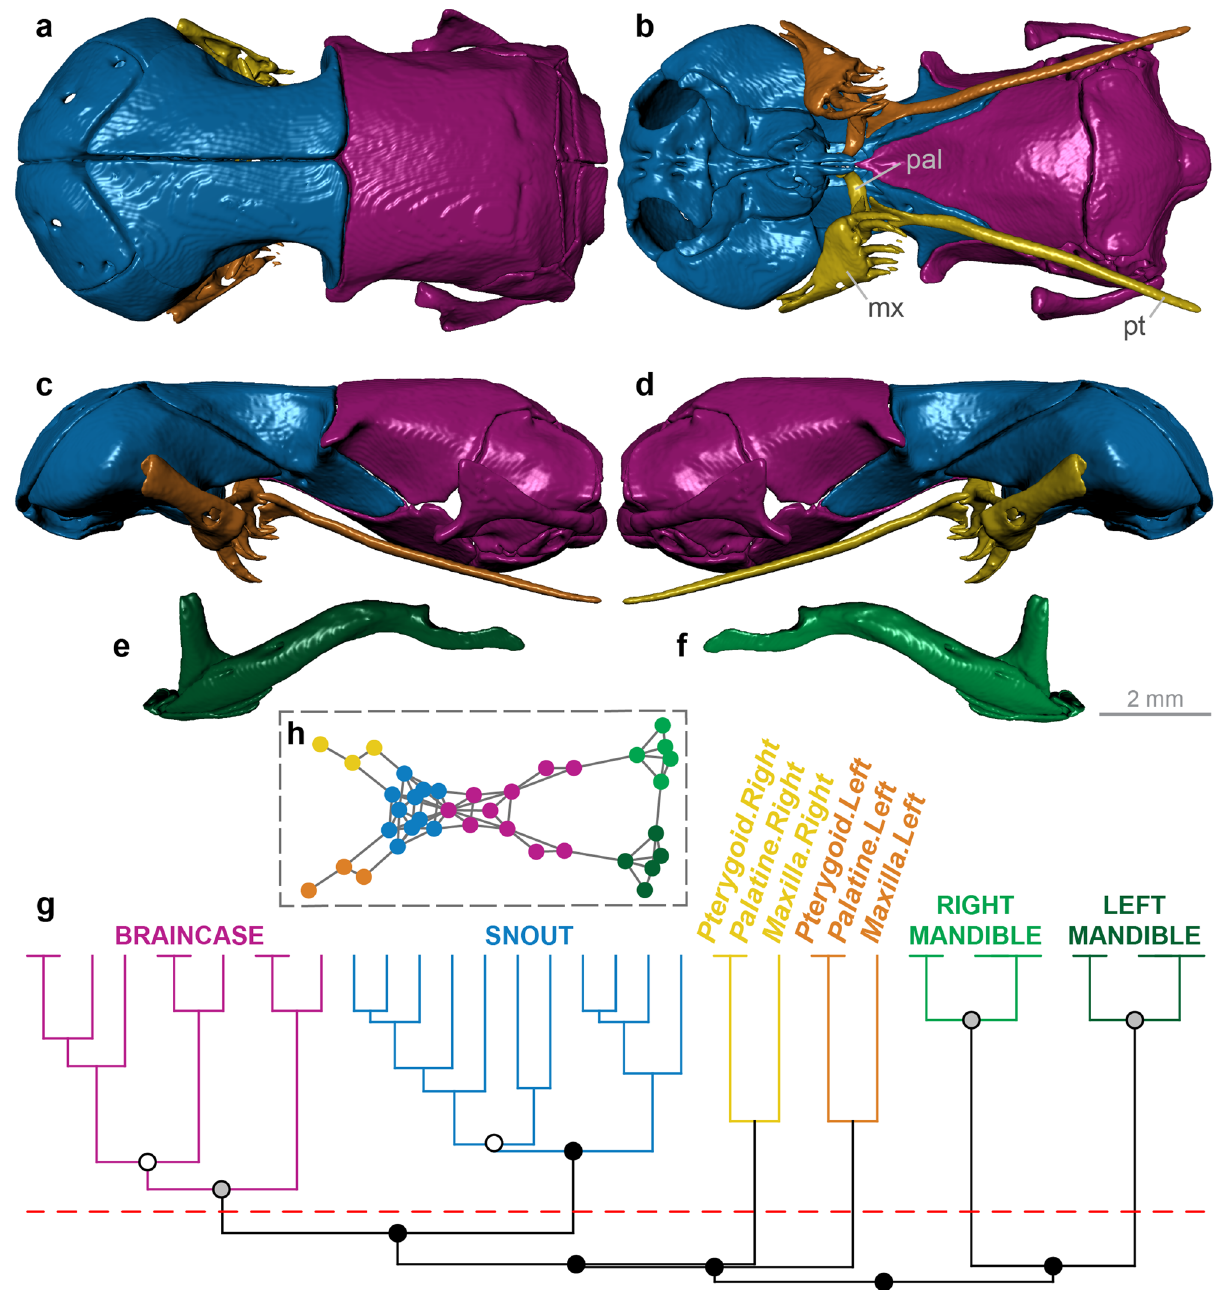
Figure 2. Skull modularity of typhlopoid scolecophidians. Typhlopoids exhibit a highly uniform network structure, including consistent formation of left and right palatomaxillary modules (in italicized boldface). ( a–f ) Typical pattern of typhlopoid skull modularity, illustrated using Afrotyphlops angolensis (MCZ R-170385) in ( a ) dorsal, ( b ) ventral, ( c ) left lateral, and ( d ) right lateral views of the skull, and ( e ) left lateral and ( f ) right lateral views of the mandible. ( g ) Network dendrogram of Xenotyphlops grandidieri (ZSM 2194/2007), reflecting this general typhlopoid network structure. Q-modules are indicated by Q max (represented by the red dotted line). S-modules are indicated by black (p < 0.001), grey (0.001 ≤ p < 0.01), or white (0.01 ≤ p < 0.05) circles. ( h ) Network representation of the skull of Xenotyphlops (see Supplementary Fig. S58 for labelled version). mx maxilla, pal palatine, pt pterygoid. Dendrogram and network generated in R [v.4.0.3] 122 and